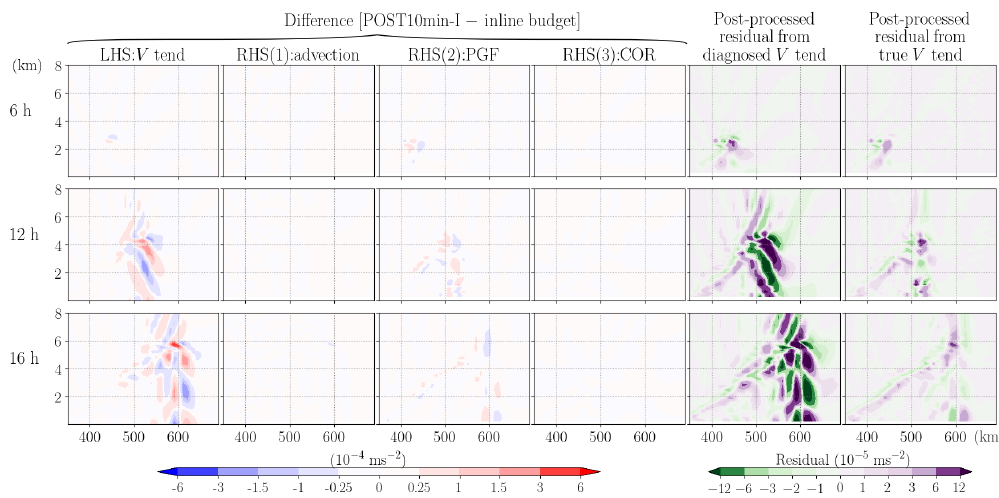
Figure 10. Same as Fig. 8, but the post-processed rhs terms are diagnosed using the implicit or backward method (POST10min-I) and an extra column is added on the rightmost showing the residual from the true tendency (i.e., the instantaneous value obtained from the model).